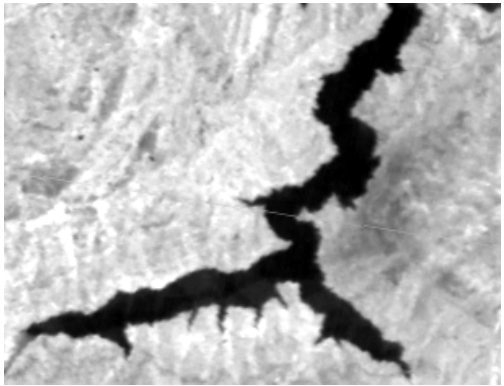
Figure 4. Cbers4 image of Guojiaba Town in Three